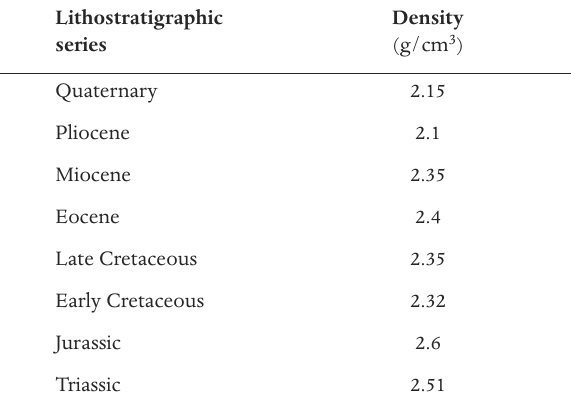
Table 1. Average density for different lithostratigraphic series in the Thibar area.